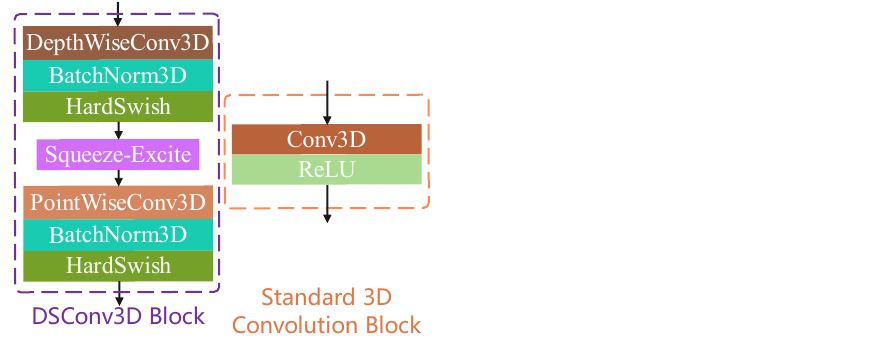
Figure 6. The difference between the DSConv3D block and a standard 3D convolution block. The DSConv3D block is composed of depth-wise convolution 3D [52], batch nor- malization 3D [53], point-wise convolution 3D [52], and HardSwish nonlinear activation function